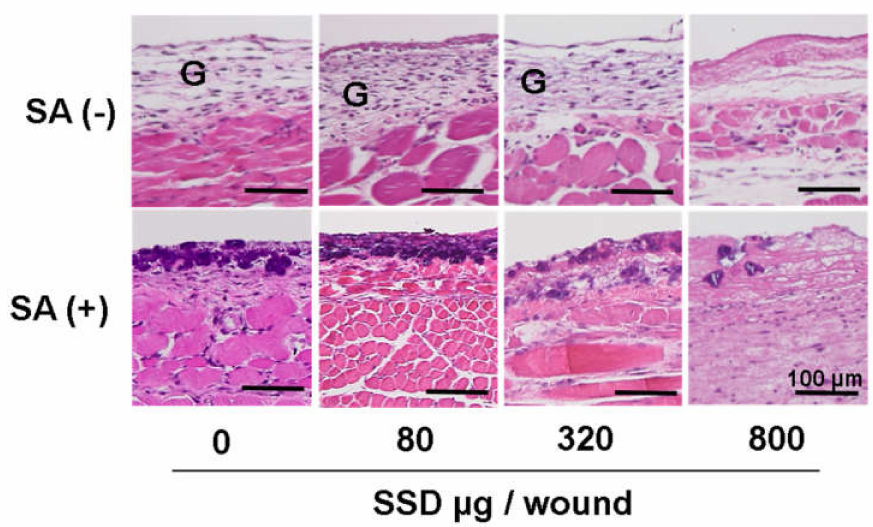
Figure 8. The effects of SSD on S. aureus -infected wounds in mice. S. aureus (SA) was inoculated 3 days after back skin excision, and SSD in different doses was applied onto the wound surface on day 4. Wound tissues stained by Gram + HE staining are shown on day 6. G: granulation tissue; bars = 100 µ